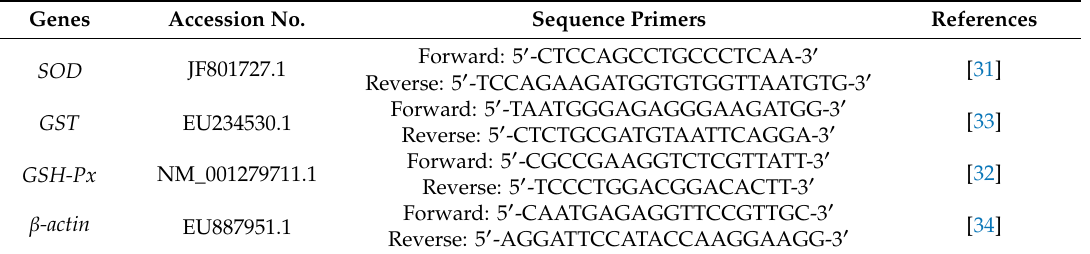
Table 2. Primer sequences of antioxidant genes used in qRT-PCR analysis in the present study. Genes Accession No. Sequence Primers